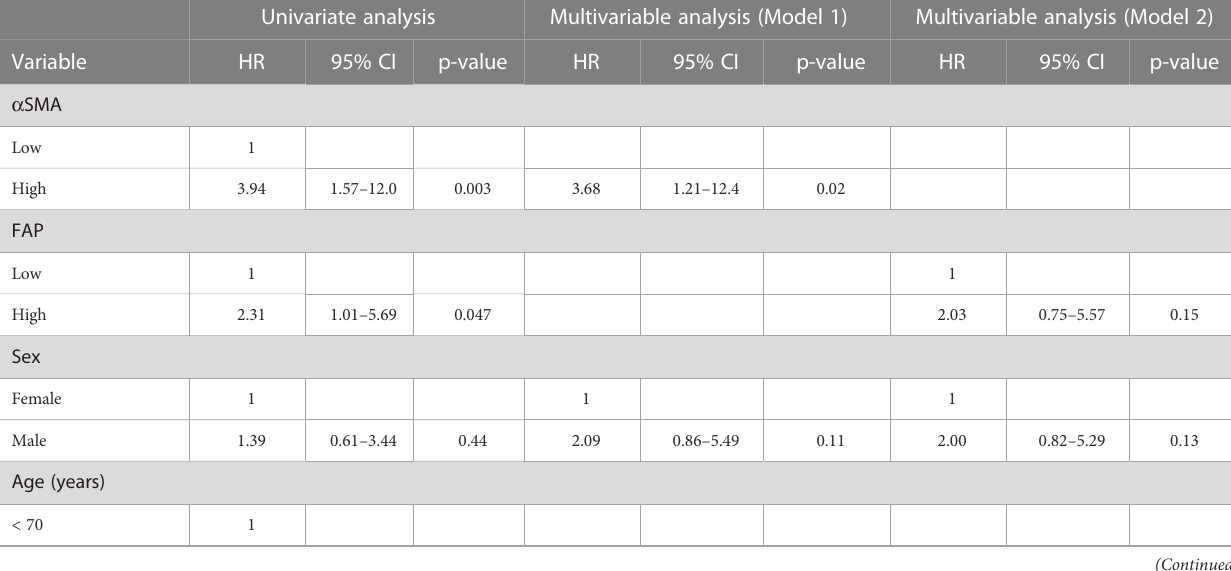
TABLE 3 Univariate and multivariable analyses of prognostic factors associated with recurrence-free survival. Univariate